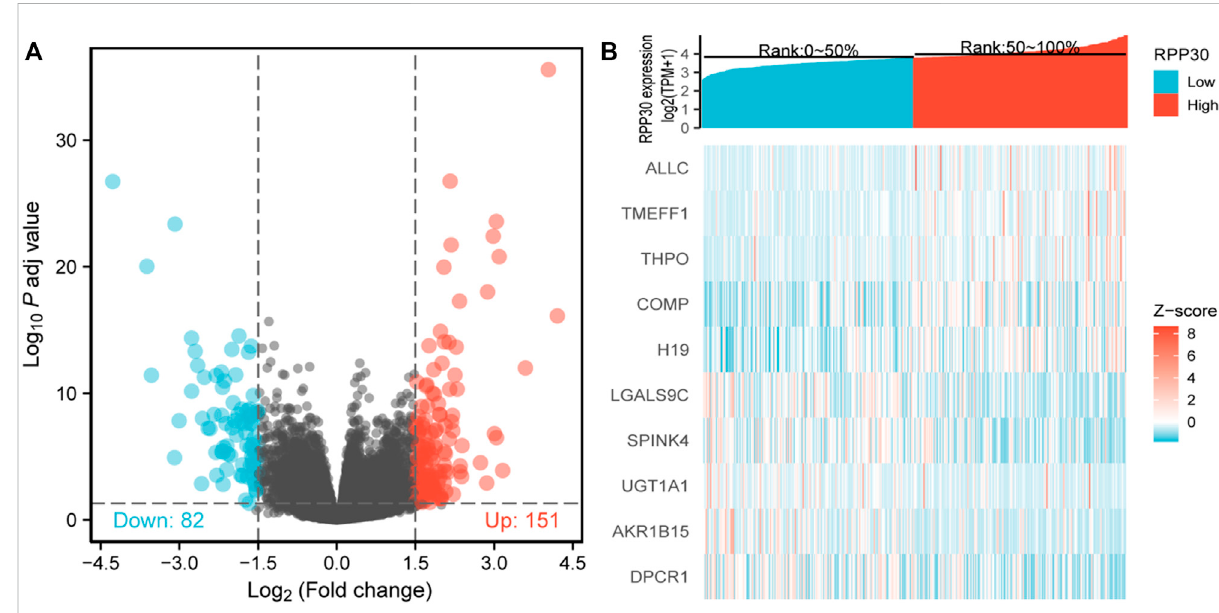
FIGURE 1 Identi fi cation of DEGs between RPP30 high and RPP30 low groups. (A) Volcano plot of DEG pro fi les between RPP30 high and RPP30 low groups. A total of 233 DEGs were obtained, of which 151 were upregulated and 82 were downregulated. (B) Heatmap of GO analysis showing the co- expression of differential gene pro fi les in TCGA between RPP30 high and RPP30 low groups. Red indicates upregulated genes; blue indicates downregulated genes; each row indicates each gene expression in different samples, whereas each column indicates the expression of all genes in each